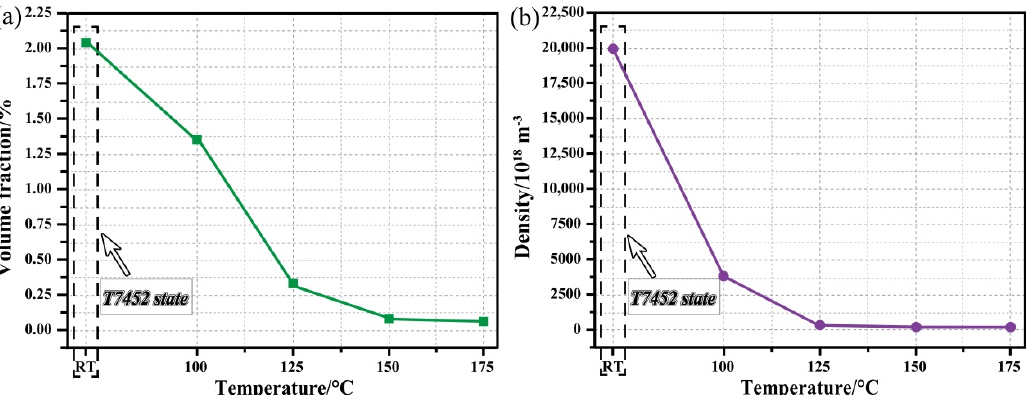
Figure 9. Evolutions of the precipitate parameters of the samples after various heat treatments: ( a ) precipitate volume fraction, and ( b ) precipitate number density.